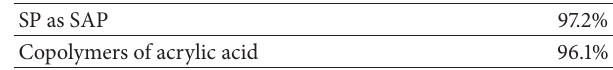
Table 1: Maximum percent desorption of water by